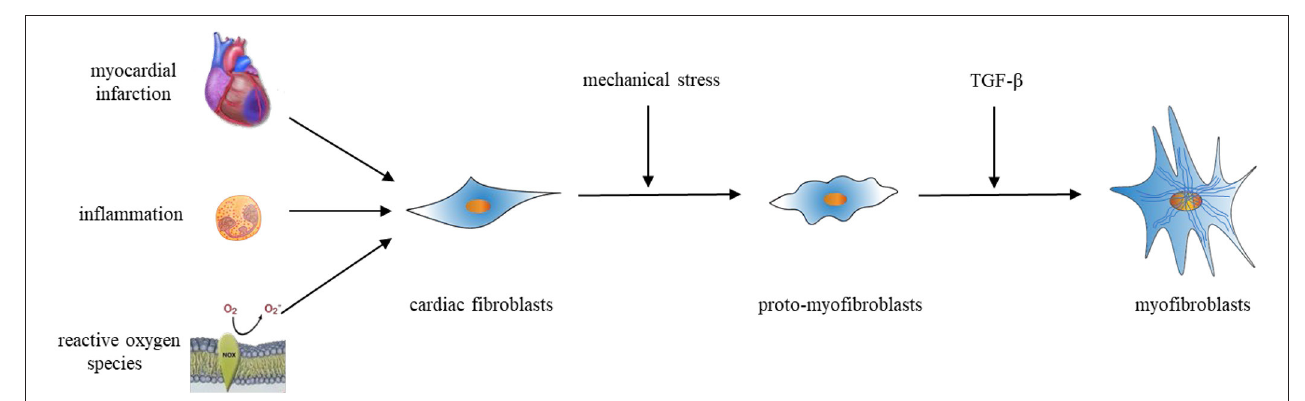
FIGURE 3 | Activation of cardiac